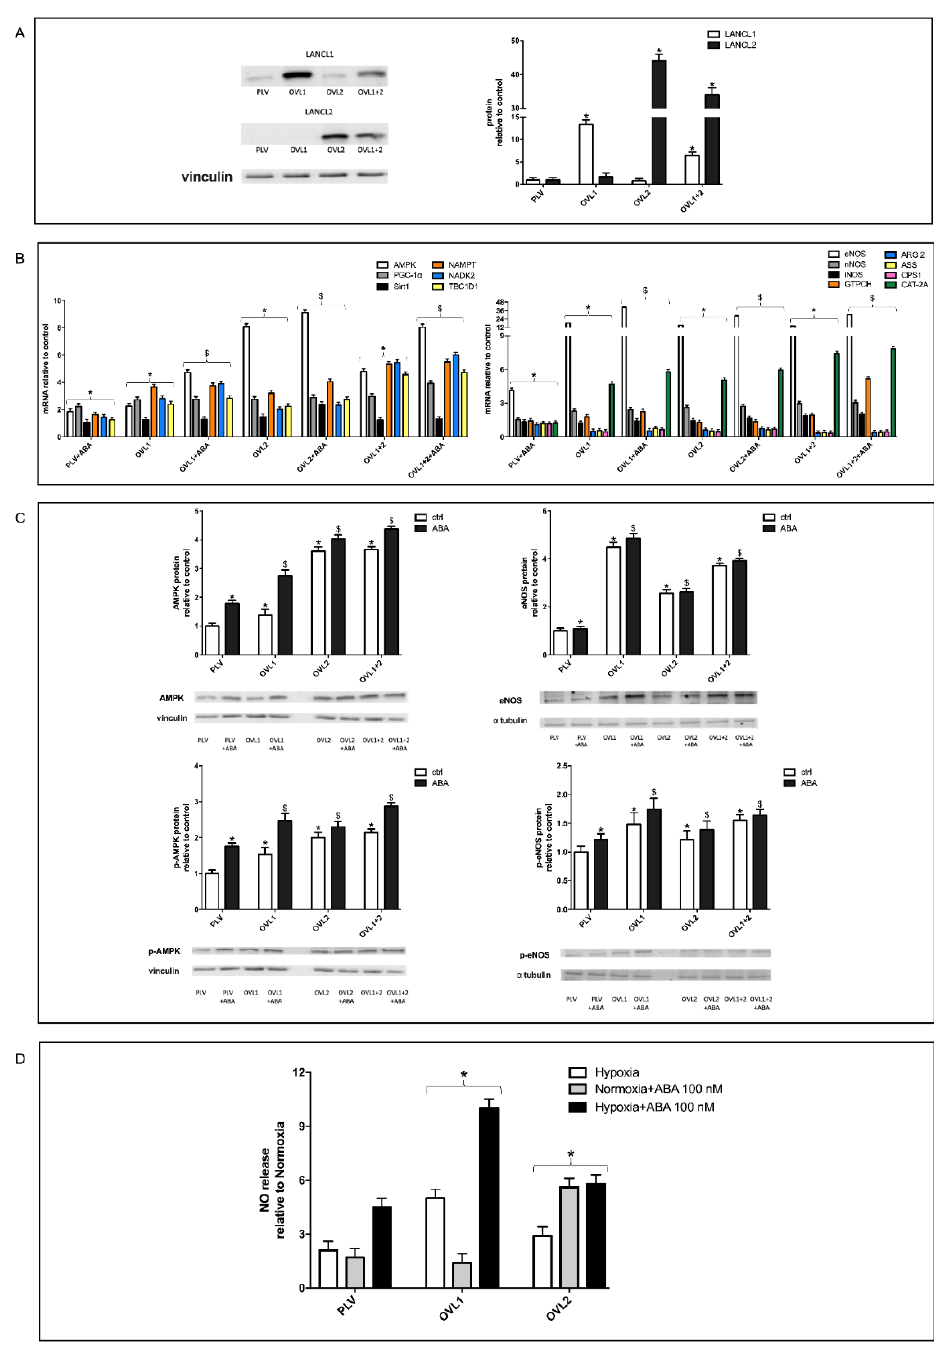
Figure 2. LANCL1 or LANCL2 overexpression stimulates eNOS transcription and phosphorylation and NO production in H9c2 under normoxia and hypoxia. LANCL1 or LANCL2 were individually overexpressed in H9c2 cardiomyocytes by lentiviral infection ( A ), and transcription of putative target genes of the ABA-LANCL1/2 system ( B ), expression and phosphorylation of AMPK and eNOS ( C ) and NO release under normoxia and hypoxia ( D ) were explored. ( A ) Left panel, representative Western blots of LANCL1 and LANCL2 protein expression in cells overexpressing LANCL1 (OVL1), LANCL2 (OVL2), both LANCL proteins (OVL1+2) or infected with the empty vector (PLV); values are normalized against vinculin, as housekeeping protein; right panel, densitometric quantitation of the LANCL proteins expression in the same cell types. ( B ) qPCR analysis of the transcription of the indicated genes in cells overexpressing LANCL1, LANCL2 or both proteins and incubated in the absence or in the presence